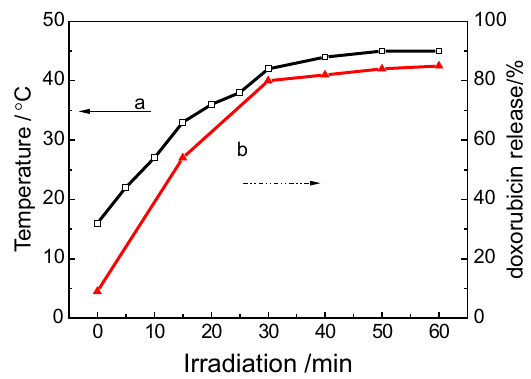
Fig. 7. Pro¯le of temperature-irradiation time of the AuNR- HM-DOX microcapsules (a) and the drug-release behavior from microcapsules under NIR irradiation